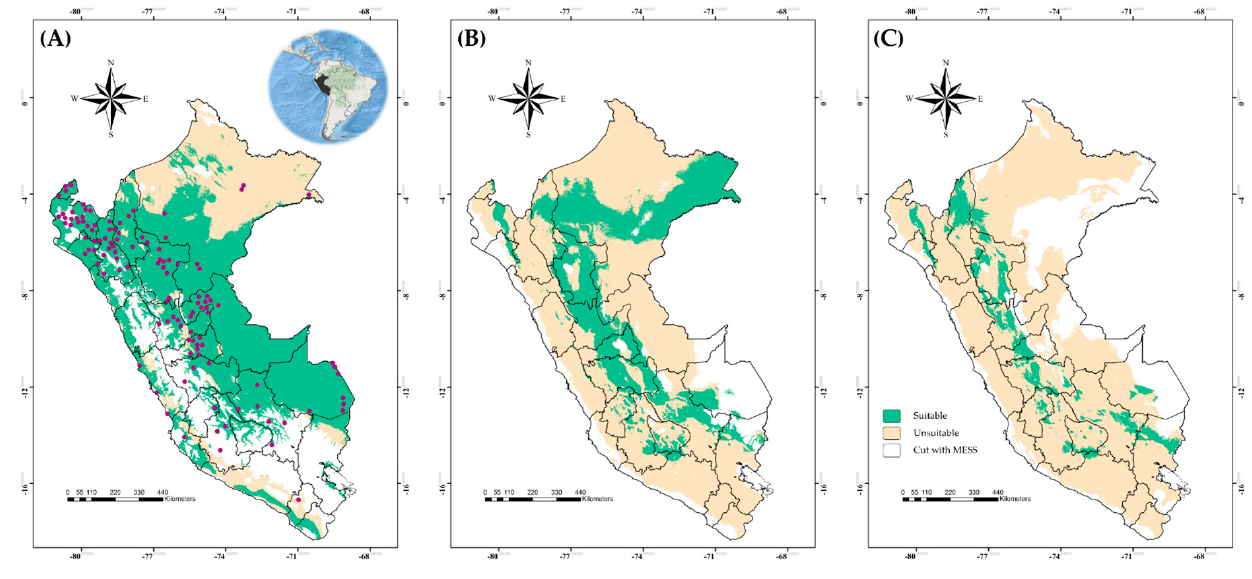
Figure 1. Suitable and unsuitable areas for the potential distribution of bluetongue virus in Peru under ( A ) the current climate scenario, and ( B ) the climate change in 2071–2100 in the future climate scenarios of SSP126 and ( C ) SSP585. Occurrence records (purple points).